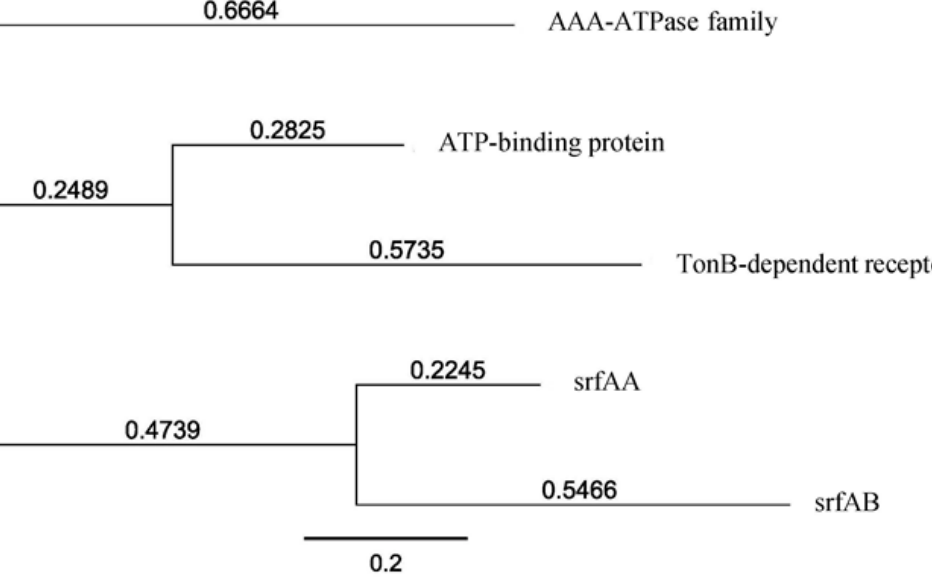
Table 2. Activity of bacterial isolates: biodegradation of propiconazole and surfactin production. Sphingomonas sp. Strains Surfactin Content (g/L)